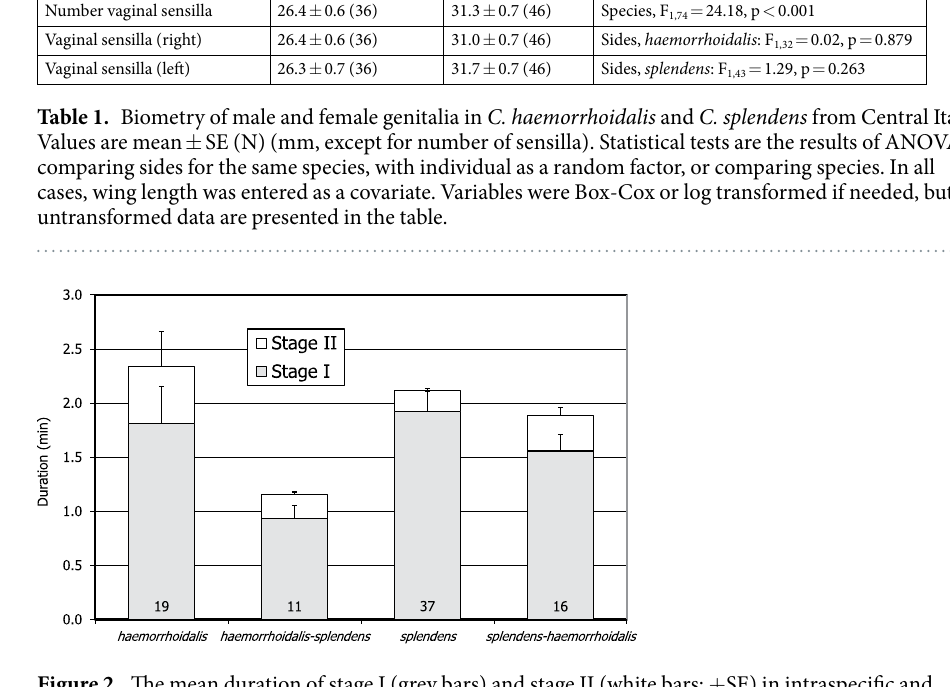
Figure 2. The mean duration of stage I (grey bars) and stage II (white bars; + SE) in intraspecific and interspecific matings between C. haemorrhoidalis and C. splendens . The sum of both stages indicates the total duration of copulation. In interspecific matings, the first name refers to the male and the second to the female. Numbers indicate sample size. Interspecific matings were significantly shorter, due to reduction in stage I, the phase when sperm removal